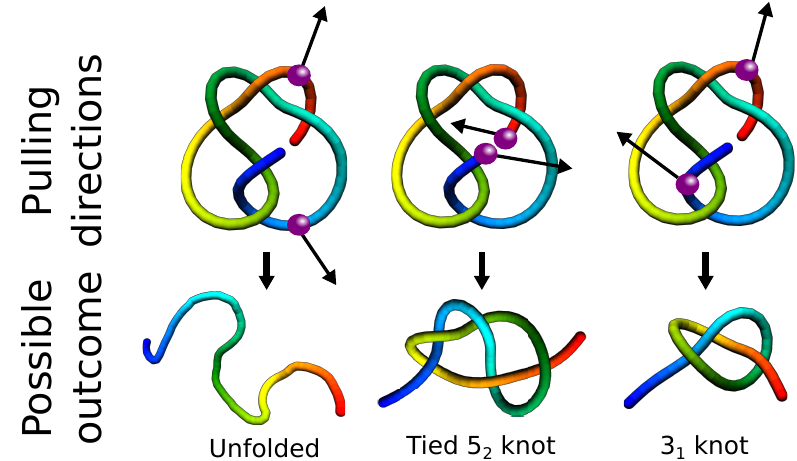
Figure 7. Upper row: Schematic representation of a 5 2 knot identified in UCH proteins, with the spheres and arrows indicating the main geometrical directions of pulling. Bottom row: The resulting final topology, respectively trivial, tied 5 2 and 3 1 knot. Directions of pulling were chosen based on